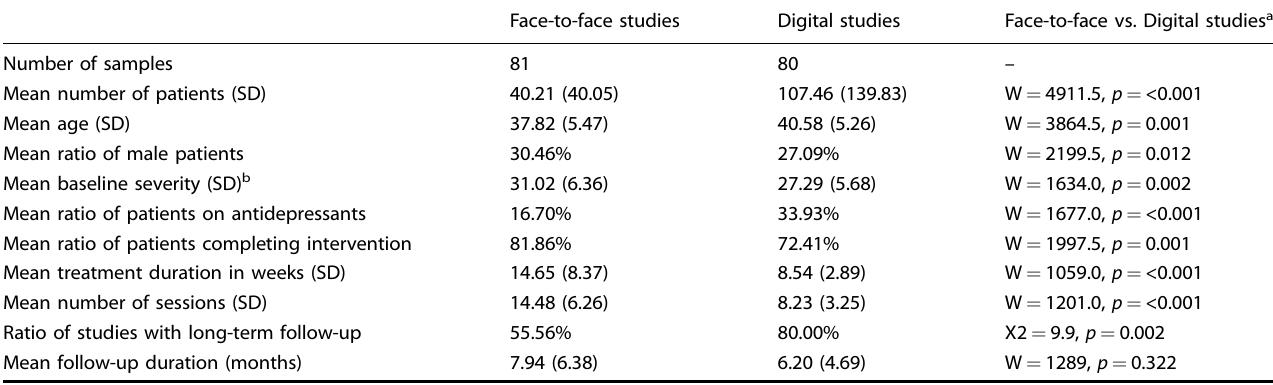
Table 1. Characteristics of face-to-face and digital CBT studies as included in the analysis of depressive symptoms (see supplement for an overview of included studies investigating psychosocial functioning and anxiety